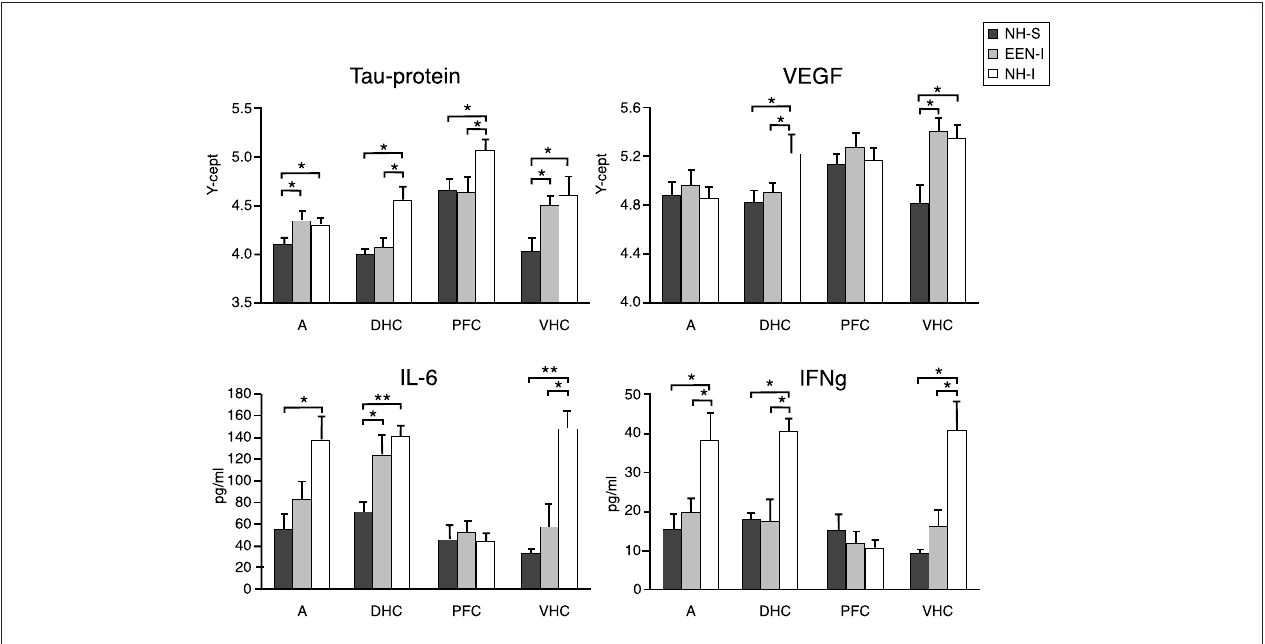
Figure 4 | Protein markers in the AD, PFC, DHC, and the VHC of animals in the various experimental groups. Tissue extracts were prepared from dissected brain regions of NH-S, NH-I, and EEN-I rats. Tissue levels of selected protein markers were assayed using either RPPM or ELISA. The